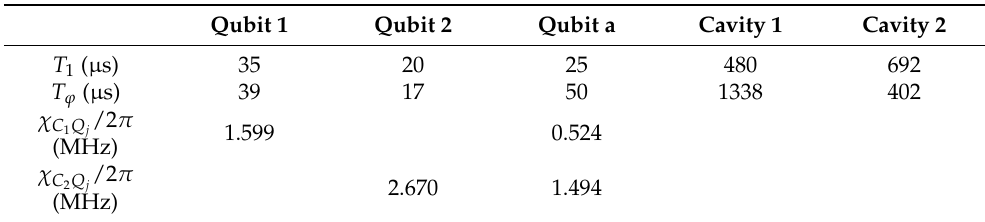
Table 1. The characteristics of the qubits and cavities. T 1 and T ϕ are the energy relaxation time and the dephasing time, and χ C ( χ C ) are the dispersive coupling strength between cavity C 1 2 Q i 1 Q i ( C 2 ) and qubit Q j . Data are taken from